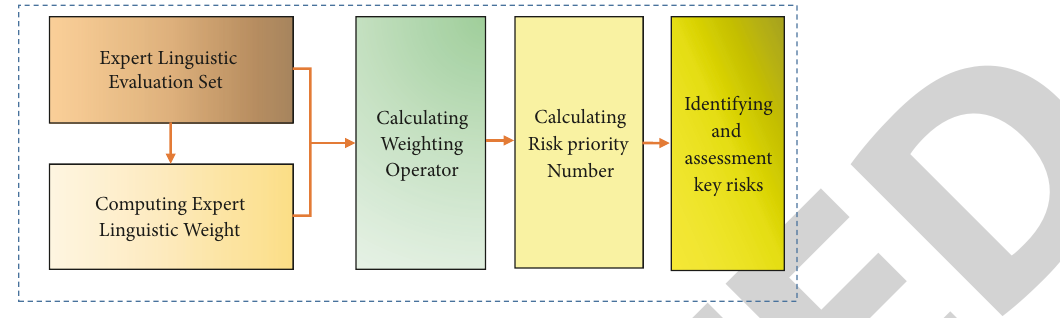
Figure 1: Improved FMEA risk factor identification